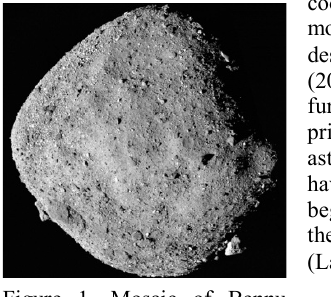
Figure 1. Mosaic of Bennu